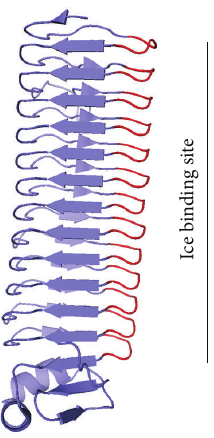
Figure 7: Protein structure of Mp AFP retrieved from RCSB Protein Data Bank (PDB). Ice binding site of the antifreeze protein lies along the aligned calcium binding turns, X-Gly-Thr-Gly-Asn-Asp. These calcium binding turns are highlighted in red using